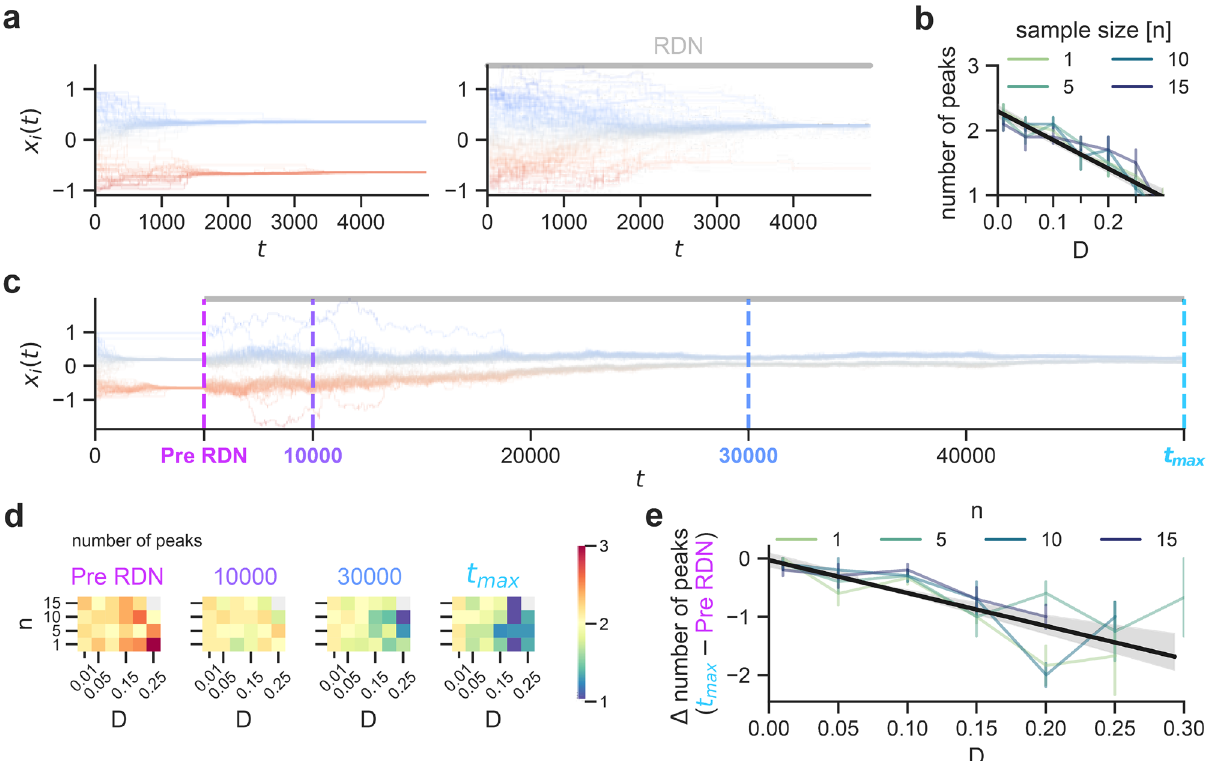
Figure 6. The RDN applied to a selective social influence model of echo chamber formation. A different opinion dynamics model that typically produces echo chambers ( a , left) 34 can prevent these echo chambers from forming by applying the RDN as in Eq. (7) ( a , right). Both simulations in ( a ) have the same seed conditions. ( b ) The number of peaks formed after a 5000 time step simulation was dependent on the RDN strength D , but not clearly on sample size n (10 trials each, bars indicate standard error of the mean). Note that the selective 10 and n 1 ) to social influence model can produce more than 2 echo chambers. ( c ) Applying the RDN ( D = = 50000 ). ( d ) The an already-polarized network “Pre RDN” took longer to become depolarized, if at all ( t max = number of peaks over time for a range of n and D (average of 10 trials). By t max , most networks had stabilized, with larger D values causing fewer peaks. This change in the number of peaks between “ t max ” and “Pre RDN” is 0.3 the simulations could become numerically unstable (any change in opinion shown in ( e ). Note that for D ≥ of > 1 within 10 time steps) and were excluded (grey block in “d” indicates less than 3 stable simulations). The RDN in examples ( a , c ) has a strength ( D ) of 0.2 and a sample size ( n ) of 1. Other parameters were as in the 100 , E 400 , m 10 , ǫ 0.5 , µ 0.5 , p 0.5 , and q 0.5 authors’ original model: N = = = = = = =